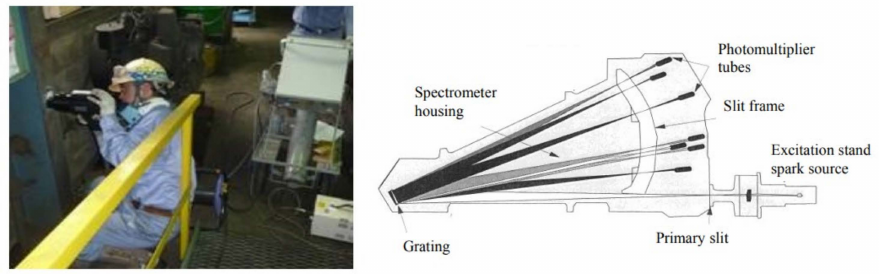
Figure 27. Optical emission spectrometer